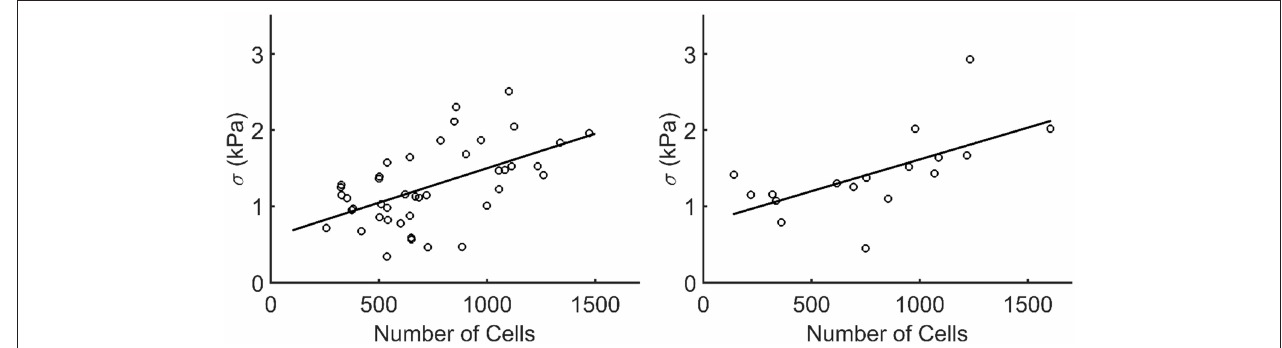
FIGURE 10 | Stress plotted against the number of cells ( N cells ) per microtissue for the statically (left) and dynamically (right) cultured groups at 72 h of culture (after recovery). Each dot corresponds to one microtissue. The black lines indicate a linear fit through all data points. The equations for these lines are σ = 0.0009 ∗ N cells + 0.5957 and σ = 0.00085 ∗ N cells + 0.7825 for the statically ( R 2 =0.55) and dynamically ( R 2 =0.62) cultured microtissues,